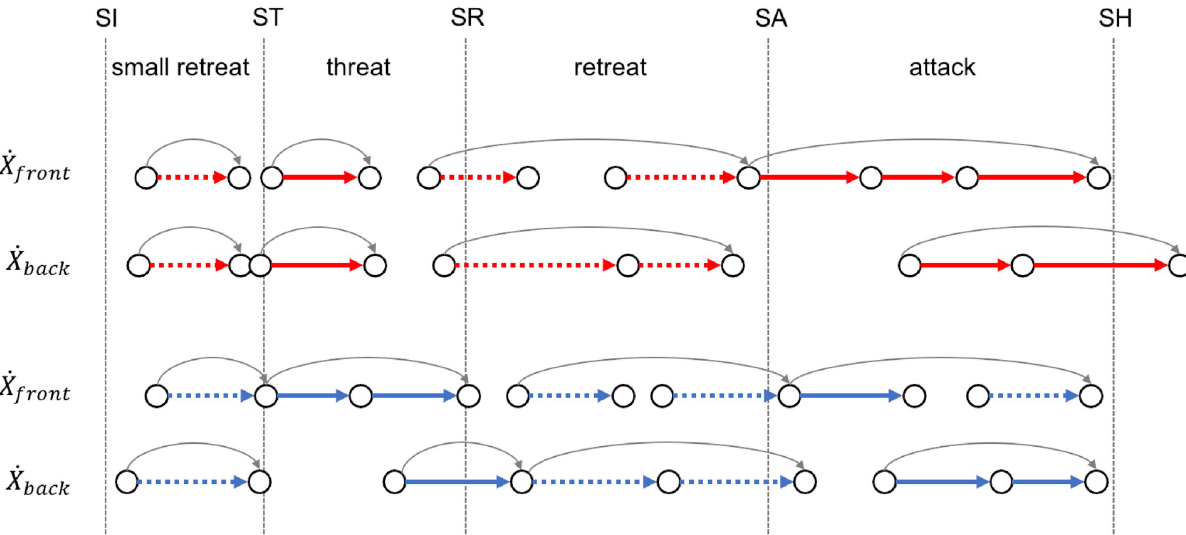
Fig 10. Motion scheme of footwork. The velocity bumps of Figs 8 and 9 determine a transition system. Each thick arrow represents a foot step forward (solid arrow) or backward (dotted arrow) for Steffen (red) and Grumier (blue). Each thin arrow (gray) represents a fencing action (small retreat, threat, retreat,